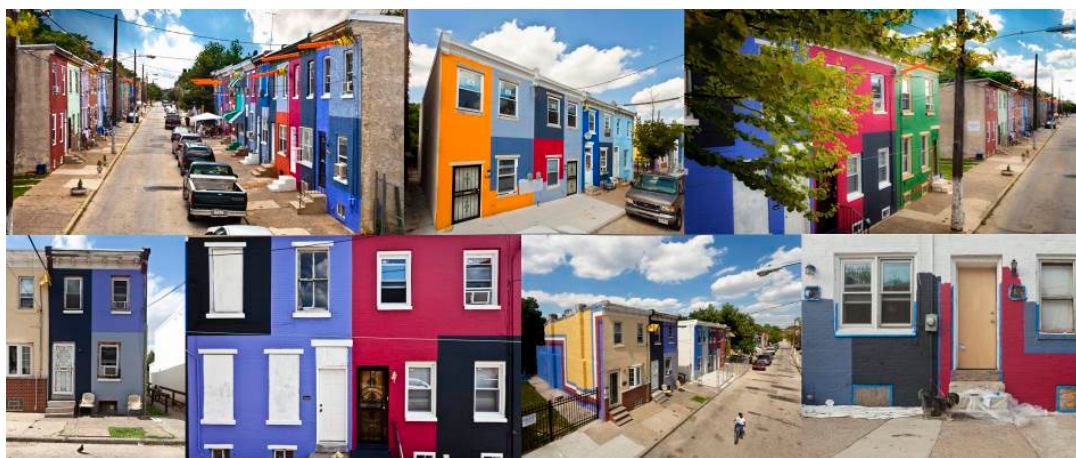
Figure 3. Pictures of the facades of houses that have been the subject of the project “A place to call home” in the city of Philadelphia.